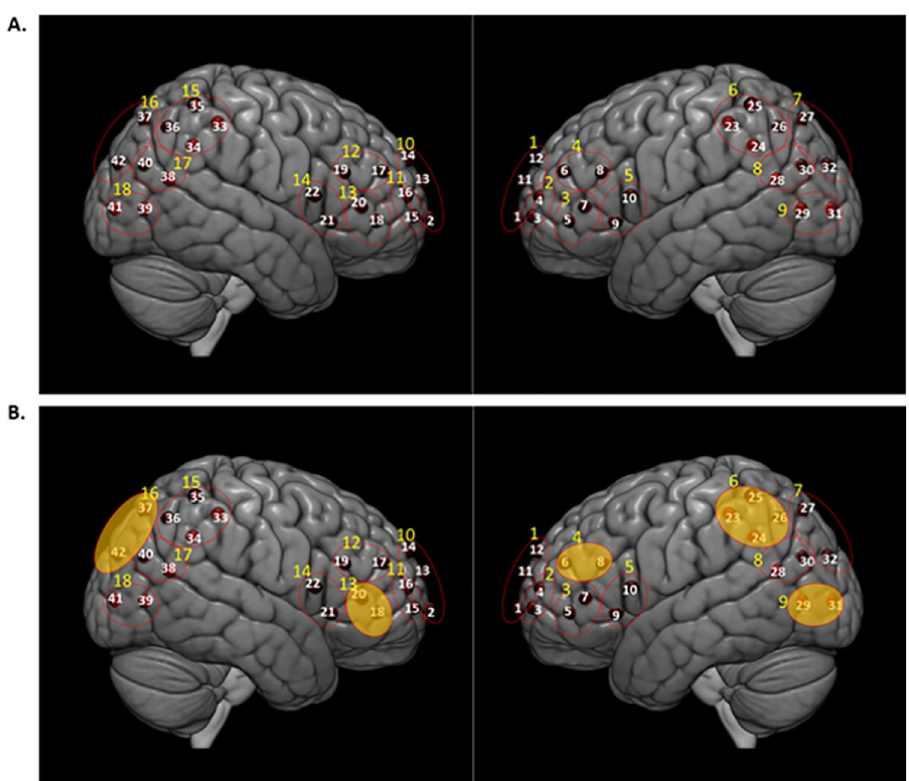
Fig 2. (A) fNIRS channel locations and functional localization into 18 ROIs based on proximity of channels and anatomy. White numbers represent channels and yellow numbers represent ROIs which include 1 = left frontopolar cortex; 2 = left middle frontal gyrus; 3 = left inferior frontal gyrus BA 47 and 45; 4 = left dorsolateral prefrontal cortex; 5 = left inferior frontal gyrus BA 44 and 45; 6 = left inferior parietal lobe; 7 = left superior parietal lobe; 8 = left temporoparietal junction; 9 = left temporo-occipito-parietal junction; 10 = right frontopolar cortex; 11 = right middle frontal gyrus; 12 = right dorsolateral prefrontal cortex; 13 = right inferior frontal gyrus BA 47 and 45; 14 = right inferior frontal gyrus BA 44 and 45; 15 = right inferior parietal lobe; 16 = right superior parietal lobe; 17 = right temporoparietal junction; 18 = right temporo-occipito-parietal junction. (B) fNIRS funny > neutral contrast significant results (p < 0.05 FDR corrected). ROIs that exhibited both HbO and HbR significant changes for funny > neutral (p < 0.05 FDR corrected) included left DLPFC (ROI 4), left IPL (ROI 6), left TOPJ (ROI 9), right IFG (ROI 13) and right SPL (ROI